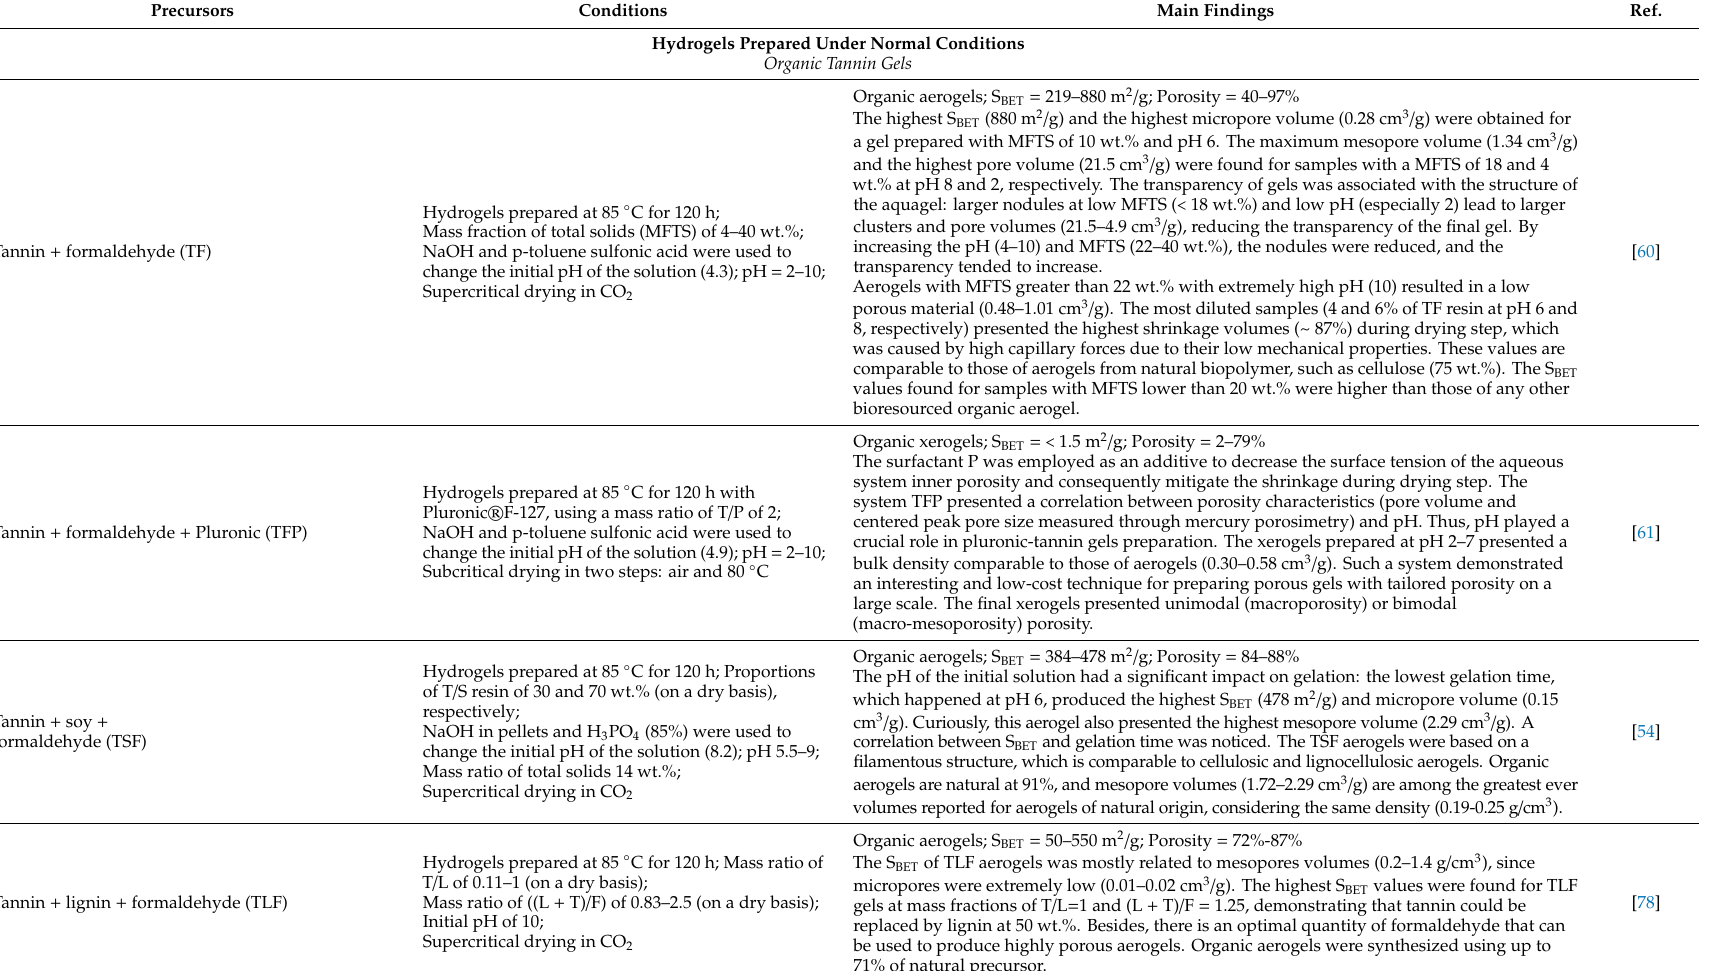
Table 1. Organic and carbon gels synthesized at normal